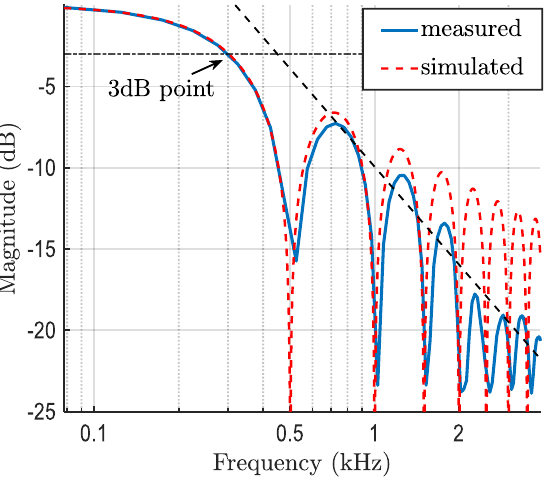
Figure 6. Measured and estimated bandwidth of the for IS with T exp of 2